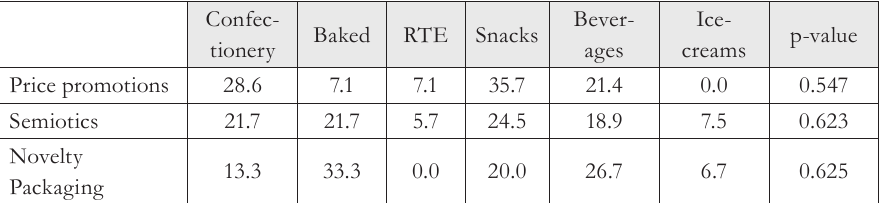
Tab. 5 - Percentage of Top Three Marketing Techniques across Food Categories. Source: